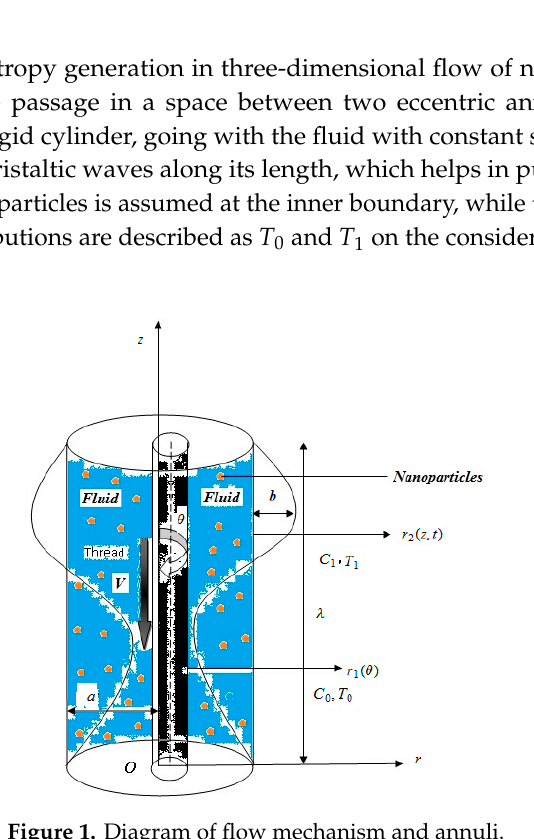
Figure 1. Diagram of flow mechanism and annuli .